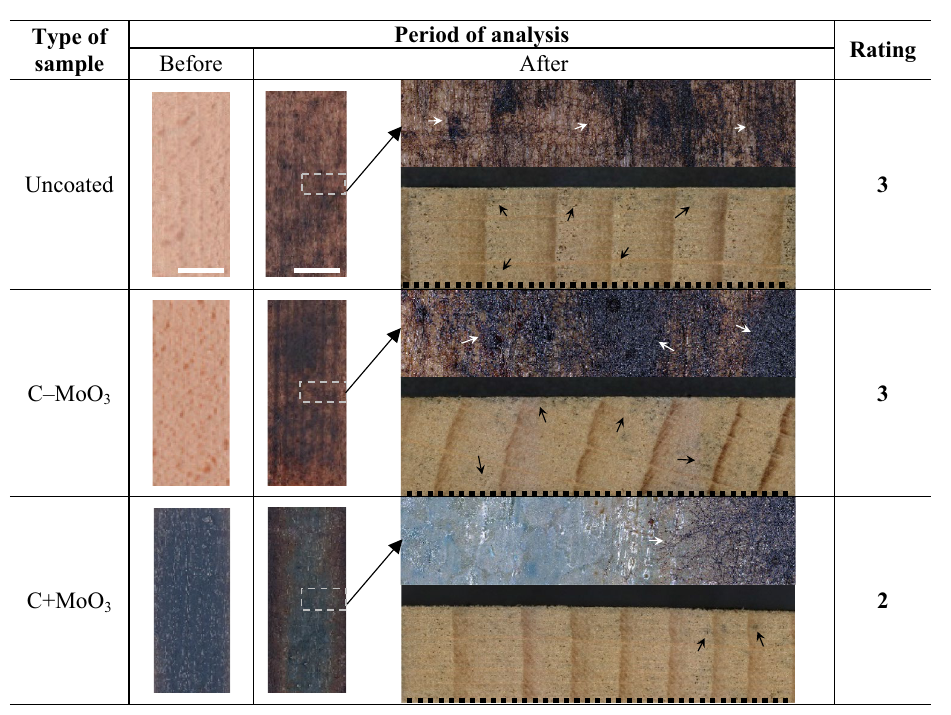
Table 3. The results of blue-stain fungal test for each type of sample and the corresponding rating. In the column “After” the upper images show the sample surface and the bottom images show the cross-section of the samples. The open arrows indicate the presence of blue-stain fungi hyphae. The dotted lines indicate an unexposed surfaces. The length of the scale bars is 10 mm.